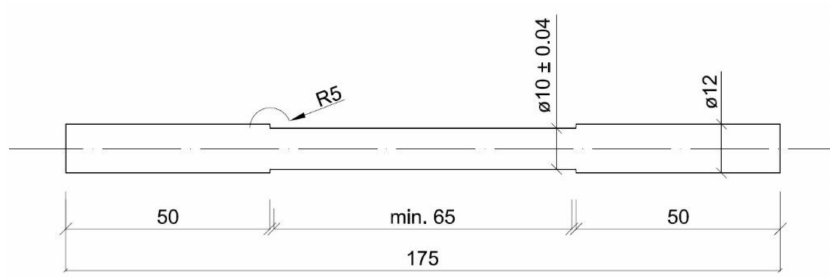
Figure 2. Sketch and dimensions of the test